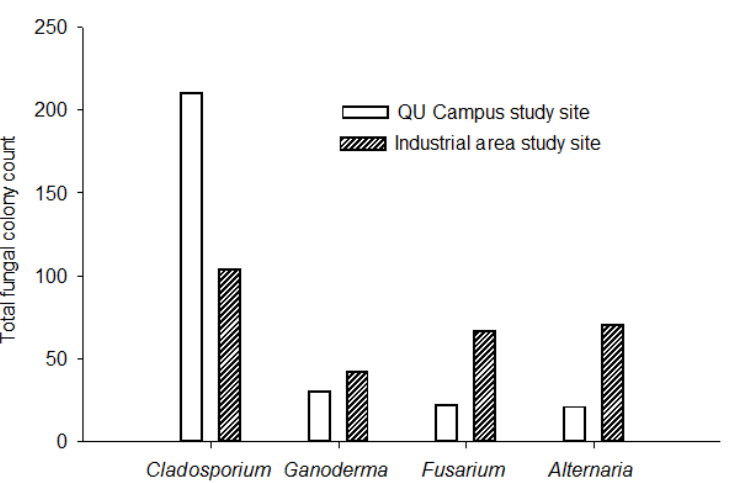
Figure 5. Fungal taxa that showed significant abundance differences between the two study sites (according to the t-test of daily colony count at p = 0.05) during the period of 1 February to 31 March 2016, with a total of 22 exposure